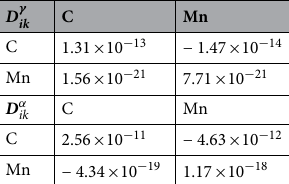
Table 4. Interdiffusivity matrix governing the evolution rate of diffusion (or chemical) potential at 878 K.